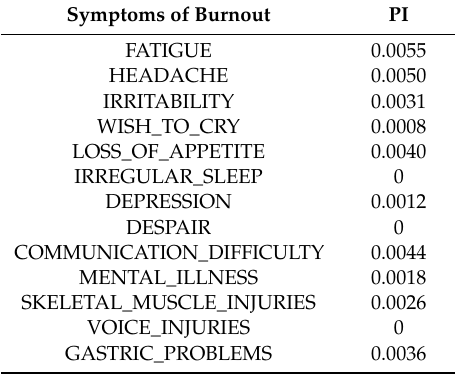
Table 4. Predictor importance (PI) of the symptoms of burnout in the RUSBoost DT model.